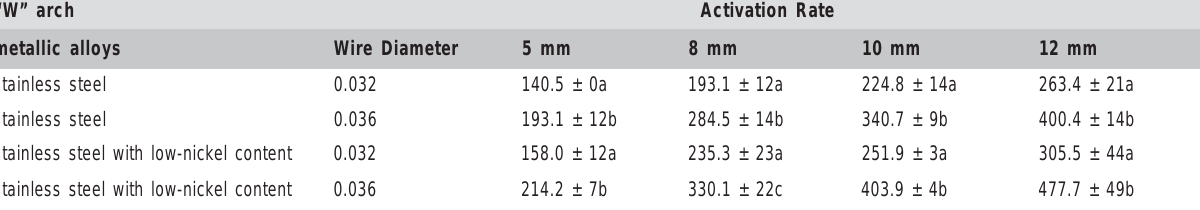
Table 2. Mean forces (g) produced by the “W” Arch appliance.